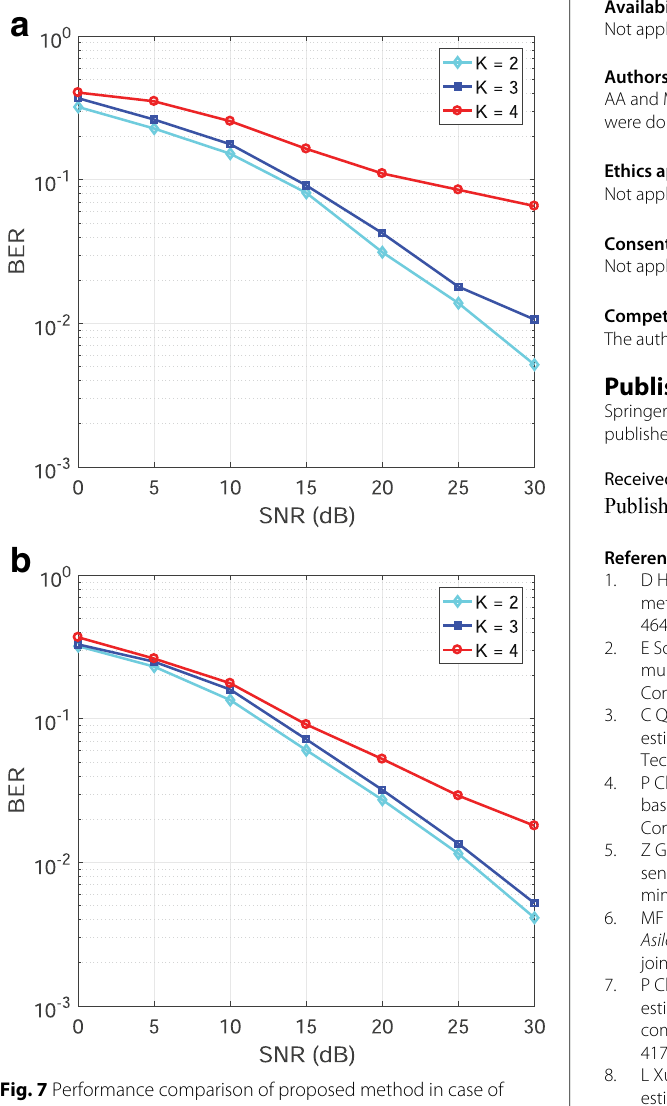
approaches. Utilizing just one local minimum point in SCE and EEDA, the performance is worse than PCE-based approach. Multi-point tracking ability of PCE makes it possible to increase the accuracy and speed of the pilot sequence determination